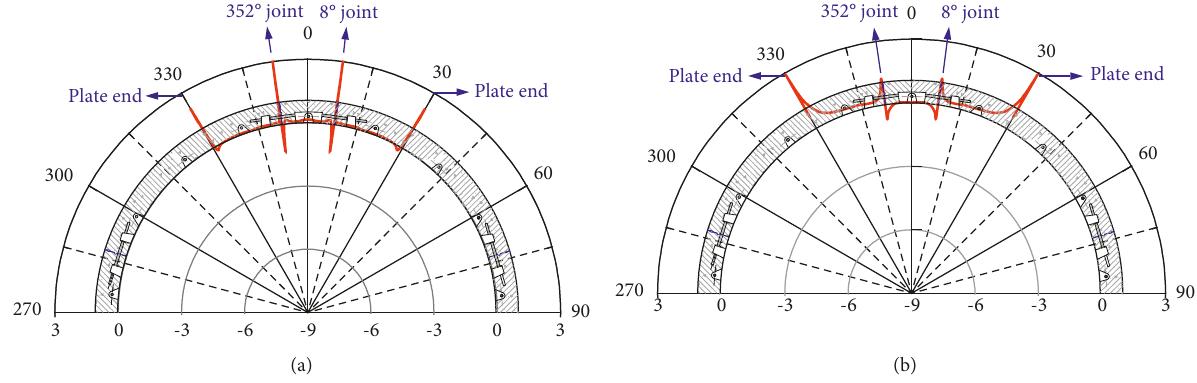
Figure 10: Interfacial stress distribution with reinforcement range of 60 ° . (a) Normal stress. (b) Shear